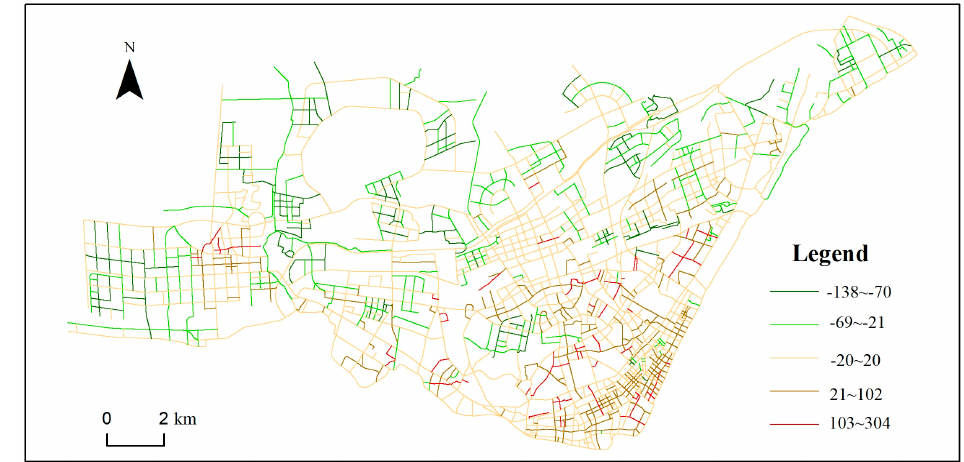
Figure 9. Changes in the order of strokes before and after the constraint of POIs.